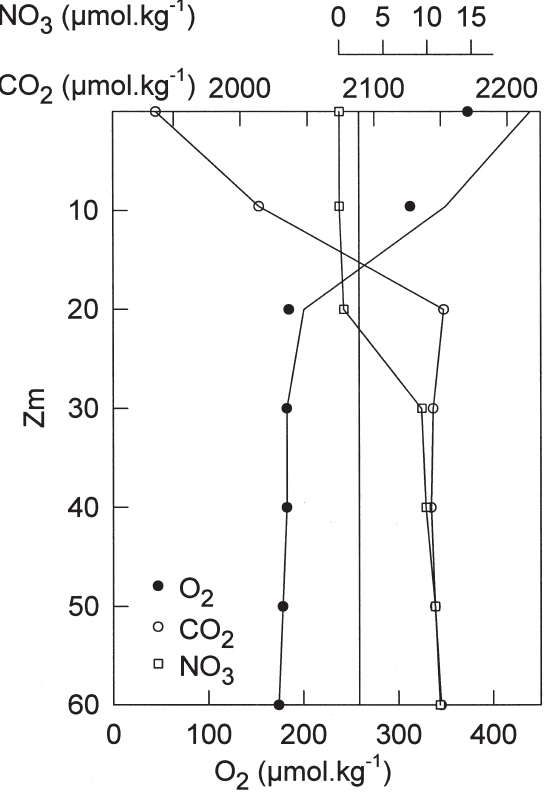
F IG . 5. – Vertical distribution of O , CO , and NO at the station in 2 2 3 Figure 4 on 25 July. The relative magnitude of each of the units is proportional to inverse Redfield stoichiometry. The preformed CO ° and NO ° values and O saturation at Z have been adjusted 2 3 2 D to the vertical line in the centre of the Figure. Solid data points are real O values; solid line represents the values adjusted for losses of 2 O to the 2